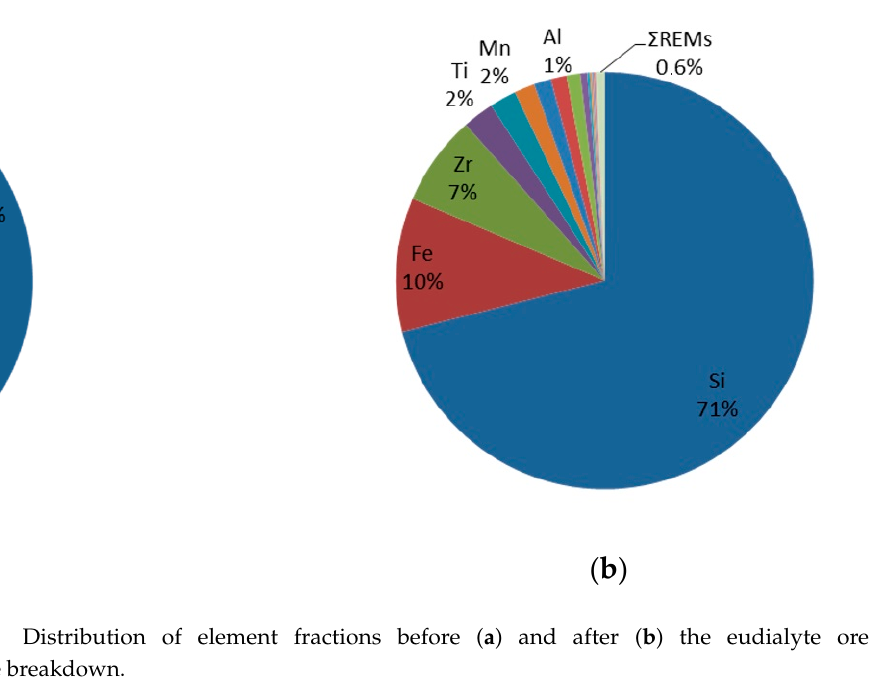
Figure 5. X-ray powder diffraction patterns of the eudialyte ore concentrate before (a) and after (b) breakdown. The obtained quantities for the minerals present in the eudialyte ore concentrate were (in wt.%): eudialyte—38, orthoclase—21.1, nepheline—12.8, albite—9.2, microcline—6.5, aegirine—4.2, amphibole—3.4, diopside—2, sodalite—1.7, titanite—0.7, and loparite—0.4. Visualization of the fit is given in a difference plot in Figure 6a. The obtained quantities